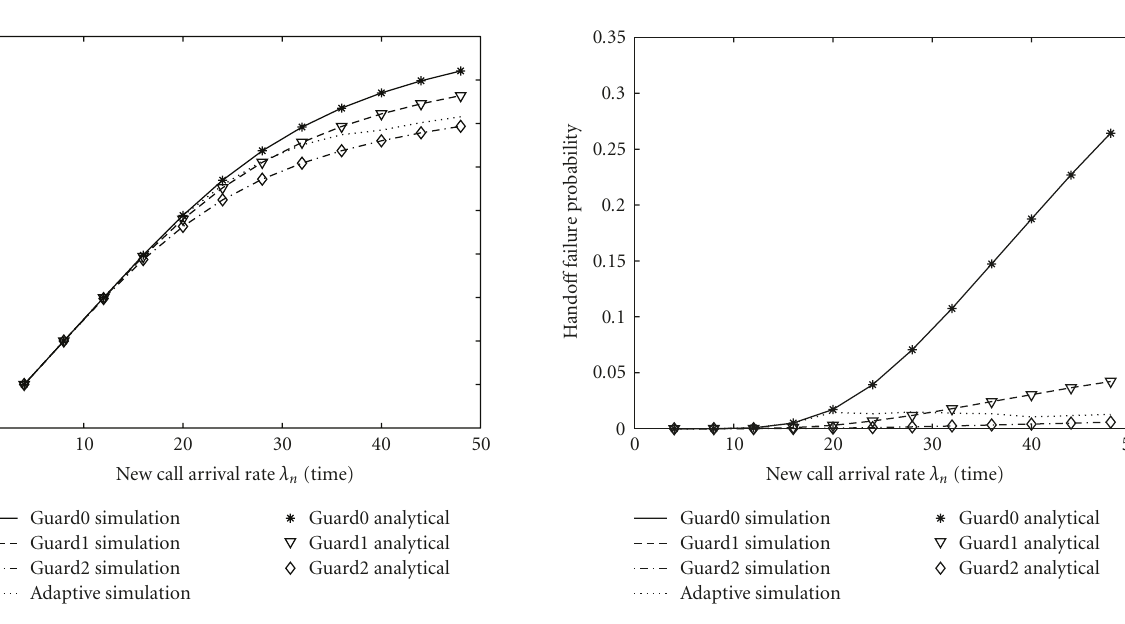
Figure 4: Analytical and simulation results of channel utilization for the two-cell system.